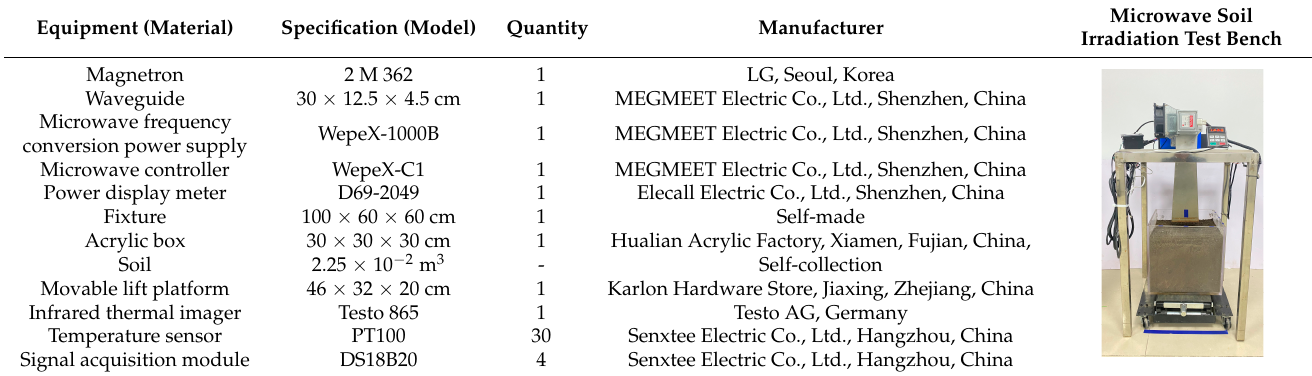
Table 2. Main equipment and materials of the microwave soil irradiation test bench.